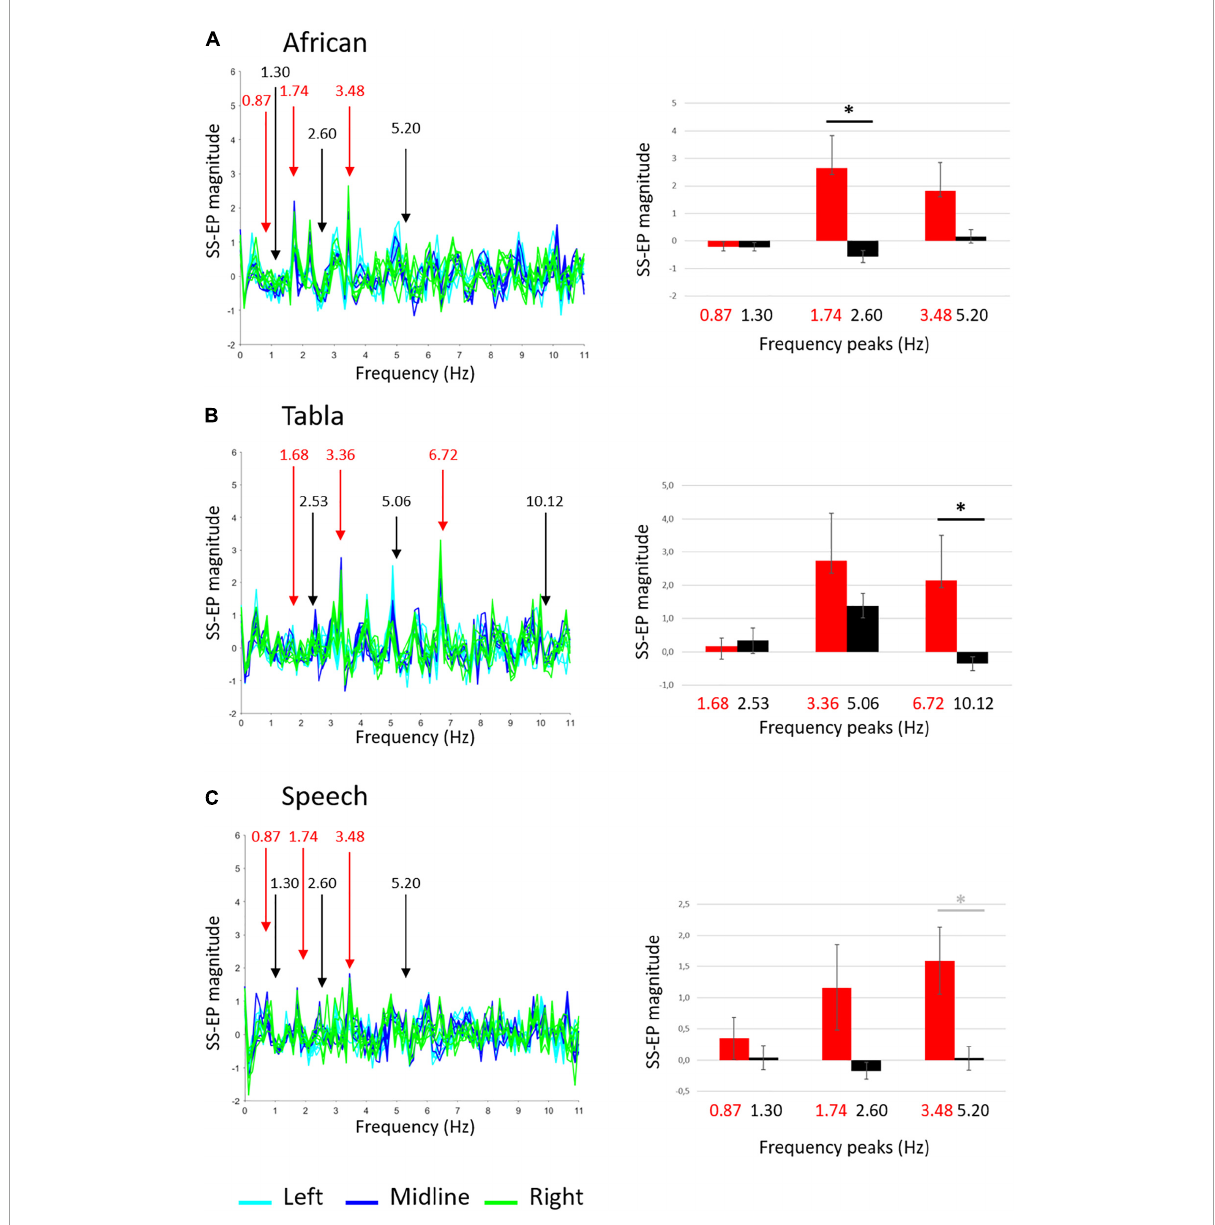
FIGURE3 Adults’ group-level average SS-EPs for the three sound stimuli: (A) African musical stimulus; (B) Tabla musical stimulus; (C) Speech stimulus. On the left, butterfly plot of SS-EPs obtained applying the Signal-to-Noise correction ( x -axis: frequency; y -axis: SS-EP magnitude). All EEG channels included in the clusters are plotted (Left: light blue lines, Midline: blue lines, Right: green lines). Peaks at frequencies corresponding to the rhythm envelope are highlighted in red, whereas peaks at frequencies not corresponding to the rhythm envelope, considered as noise floor, are highlighted in black. On the right, bar graphs (error bars indicate SEM) show the averaged SS-EP magnitude. Significant paired t -tests are indicated by black asterisks, whereas differences not surviving False discovery rate (FDR) correction are indicated by gray